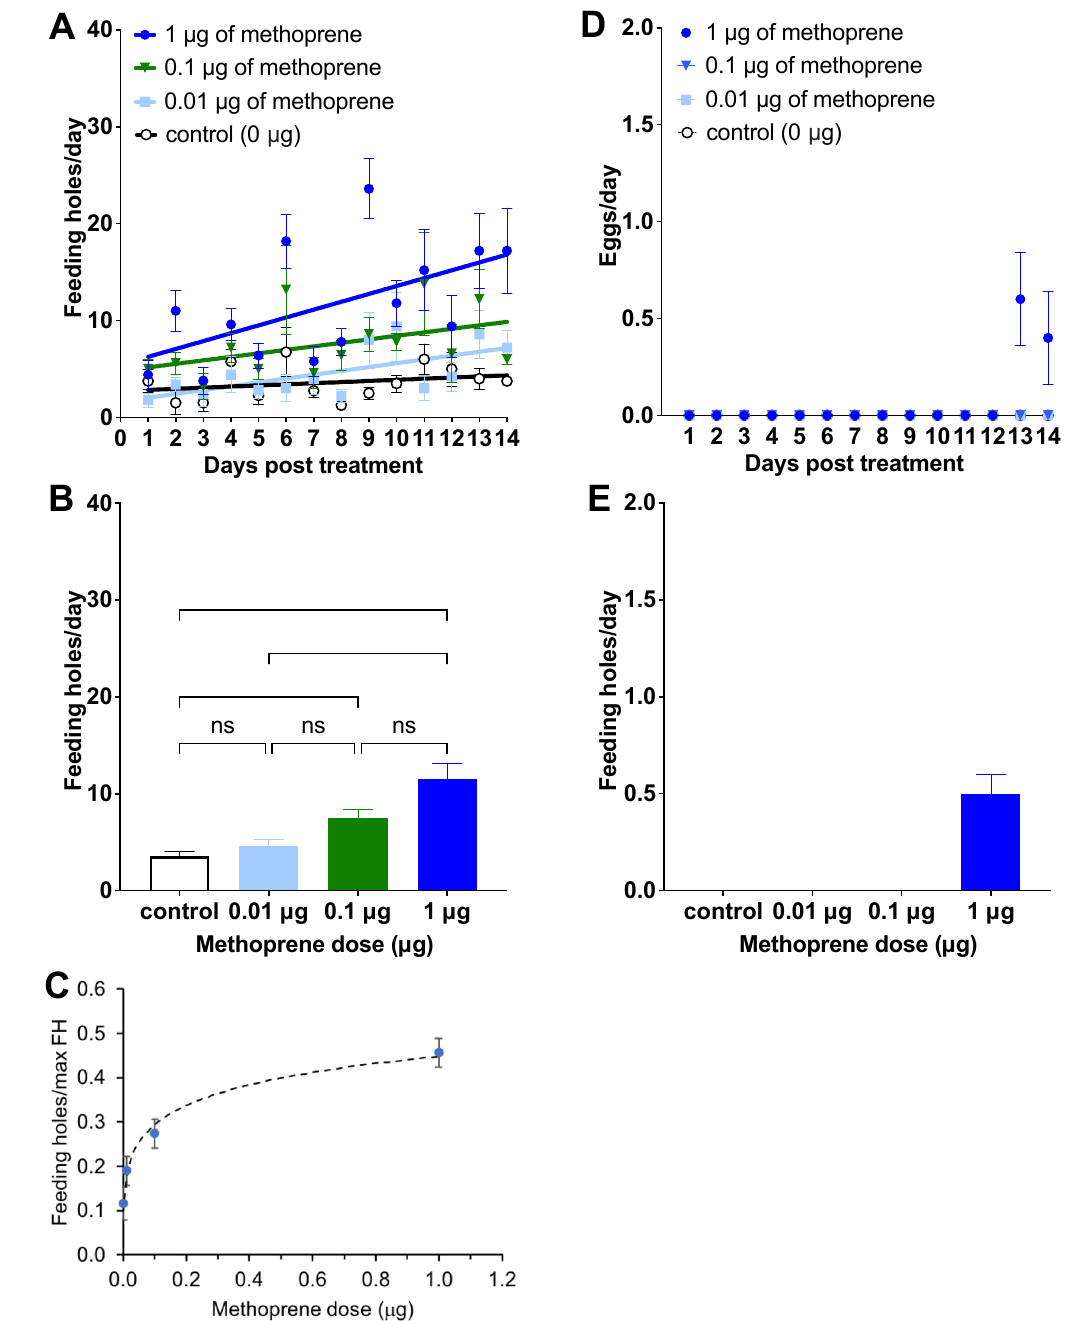
Figure 1. Effect of different doses of methoprene on feeding rate (( A )—feeding rate over time after treatment, ( B )—mean feeding rate during 14 days; mean ± SE, ( C )—the dose response curve) and oviposition (( D )—oviposition over time after treatment, ( E )—mean oviposition during the oviposition period (Days 13–14); mean ± SE) of female C. basicorne . ns: